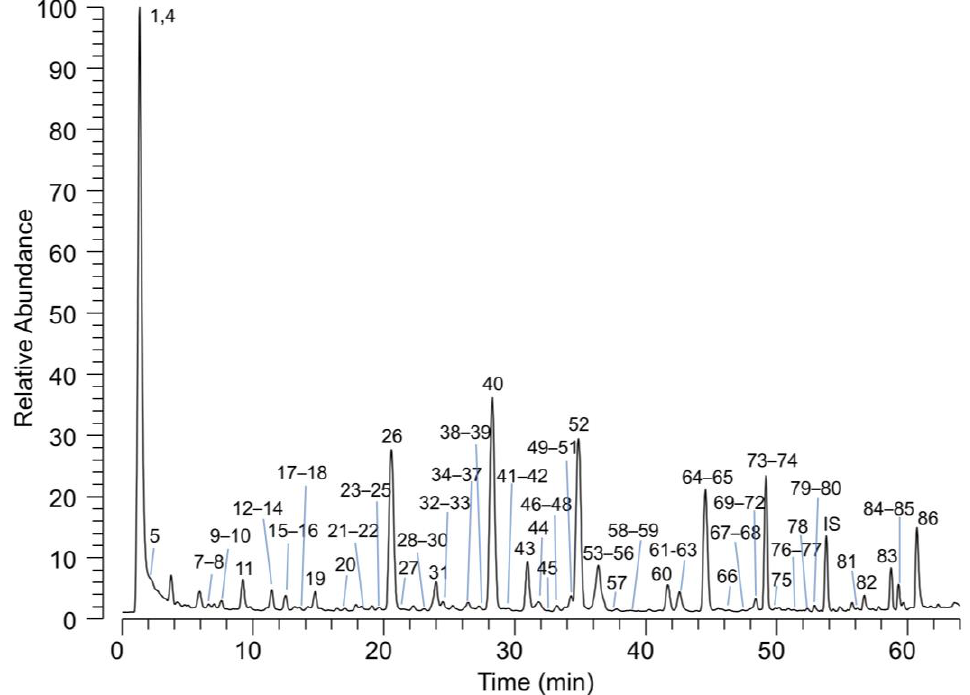
Figure 1. LC-MS total ion current chromatogram (TIC) of PBJ acquired in negative ion mode. The numbers refer to the identified compounds listed in Table